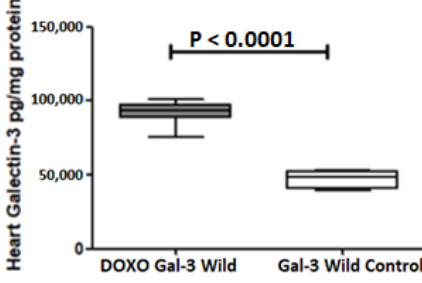
in Gal ‐ 3 wild type mice compared to their control sham. p value < 0.05 is statistically